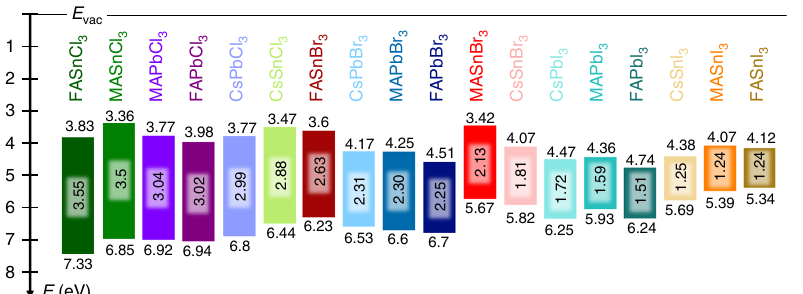
Fig. 5 Schematic energy level diagram of the 18 metal halide perovskites. The respective IE and EA values as well as the optical gaps (all in eV) are taken from Table 1; compounds are sorted in order of decreasing band gap. Minor deviations between the optical gap and the difference between IE and EA stem from the fact that one is extracted from the UV-vis measurements and the other from the PES investigations, which are furthermore averaged over 3 samples each; the corresponding error bars are given in Table 1 NATURE COMMUNICATIONS| (2019) 10:2560